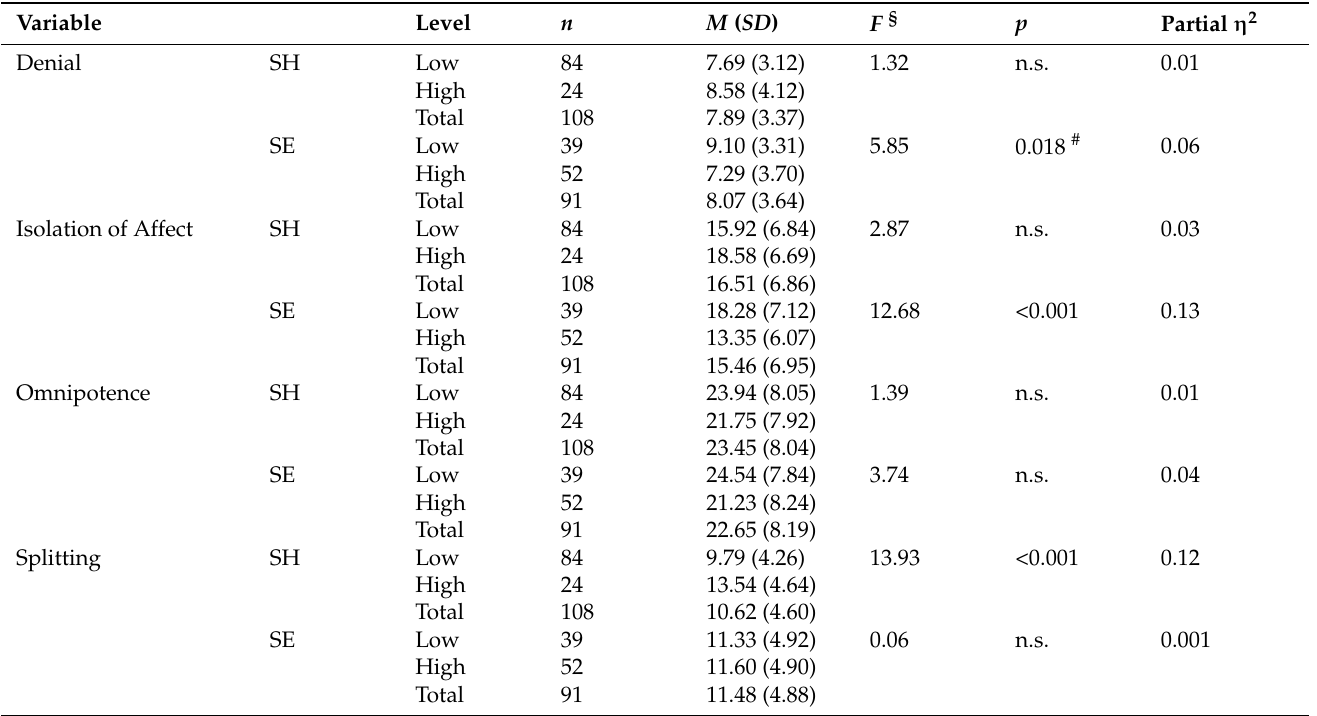
Table 5. Follow-up ANOVAs. DSQ scales by low and high Studyholism (SH) and Study Engagement (SE). Image-Distorting style.